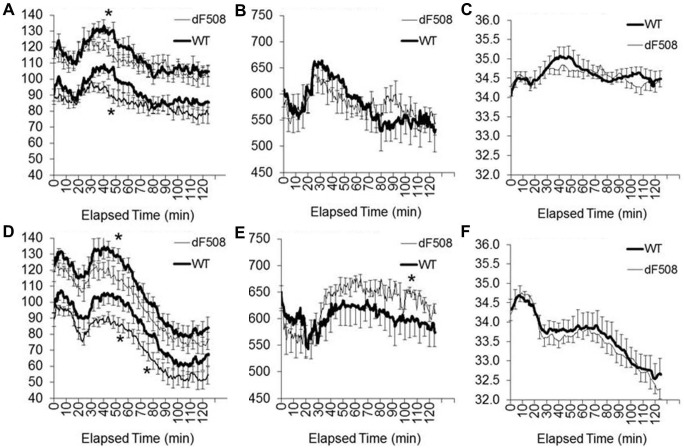
Physiological responses to β–adrenergic agonists.Twenty minutes after starting the continuous recording of arterial pressures (A), pulse rate (B) and body temperature (C), wild-type mice (WT, thick line) and heterozygous F508del mice (thin line) received normal saline (10 mL/kg i.p.). The following day, the same protocol was utilized with the injection of normal saline containing isoproterenol and epinephrine (2 mg/kg of each) (D to F). *P<0.05 versus WT; N = 14 WT and 16 F508del (injections were not given to the initial 3 WT female mice with baseline data reported in Figure 1).